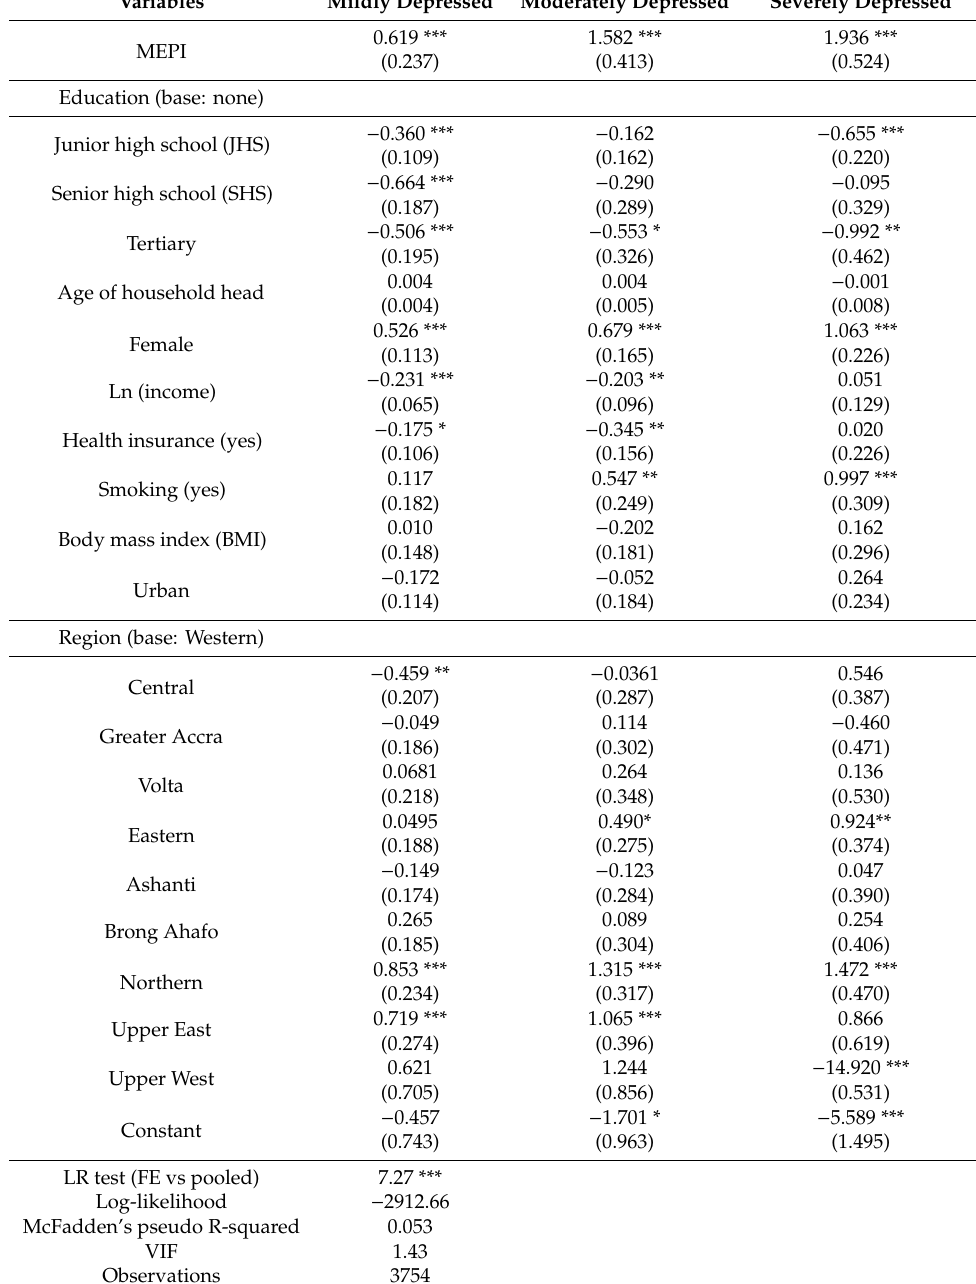
Table 4. Odds for the relationship between energy deprivation and depression in Ghana using multinomial logistic regression with fixed e ff ects